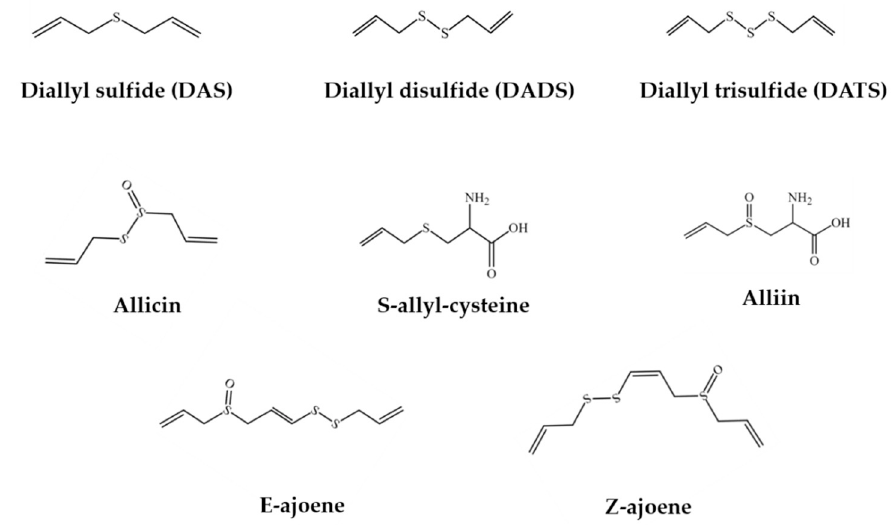
Figure 1. The chemical structures of the main organosulfur compounds in garlic.